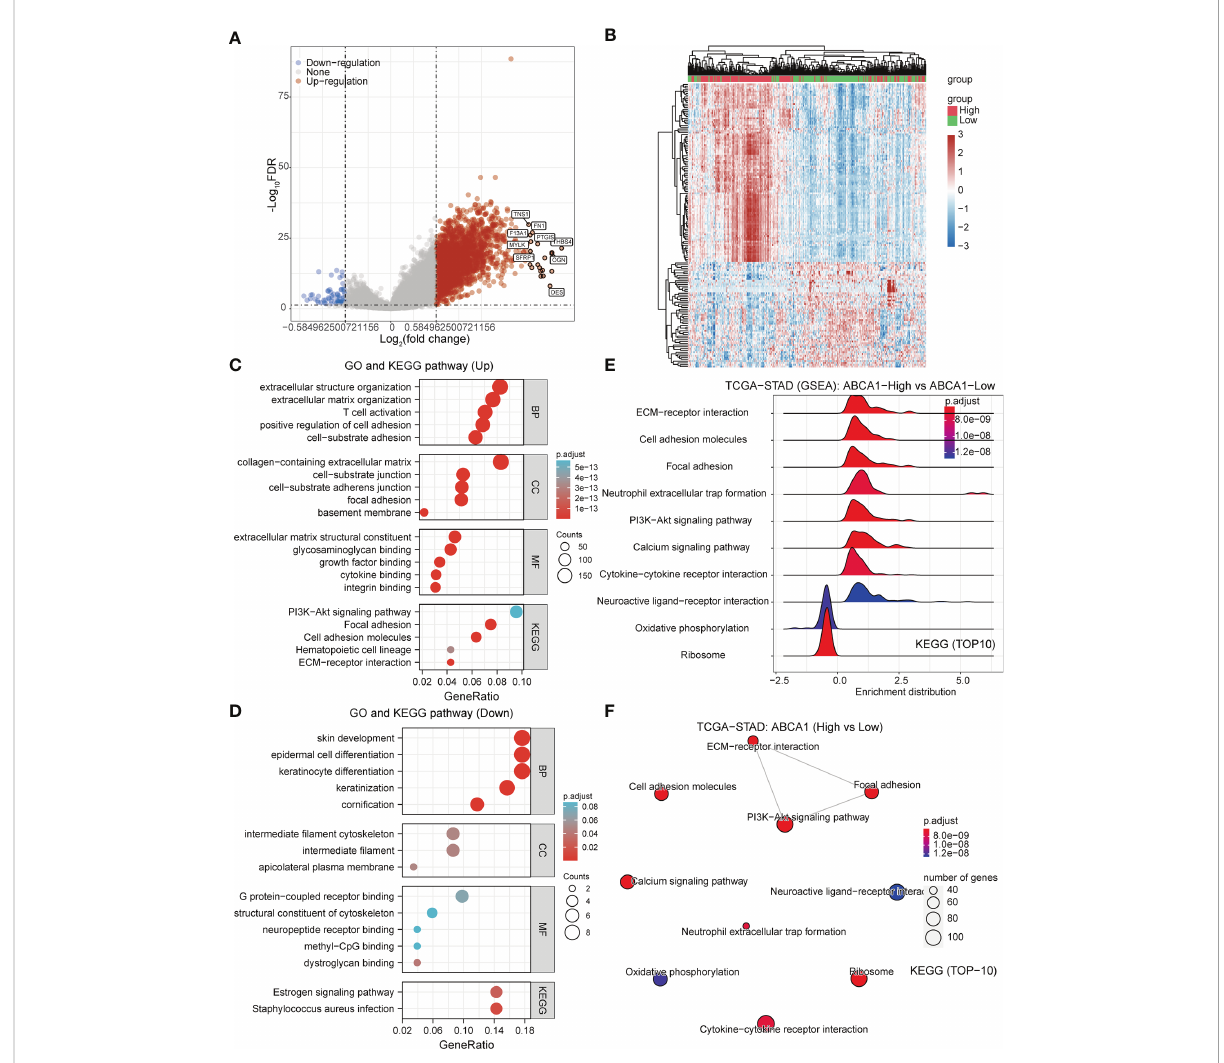
FIGURE 9 Gene function enrichment analysis of ABCA1 in STAD. (A, B) Volcano and heat maps of DEGs in the ABCA1 high and low expression groups in the TCGA-STAD cohort. (C, D) GO and KEGG pathway enrichment analysis of DEGs in STAD. (E, F) GSEA analysis based on ABCA1 expression in